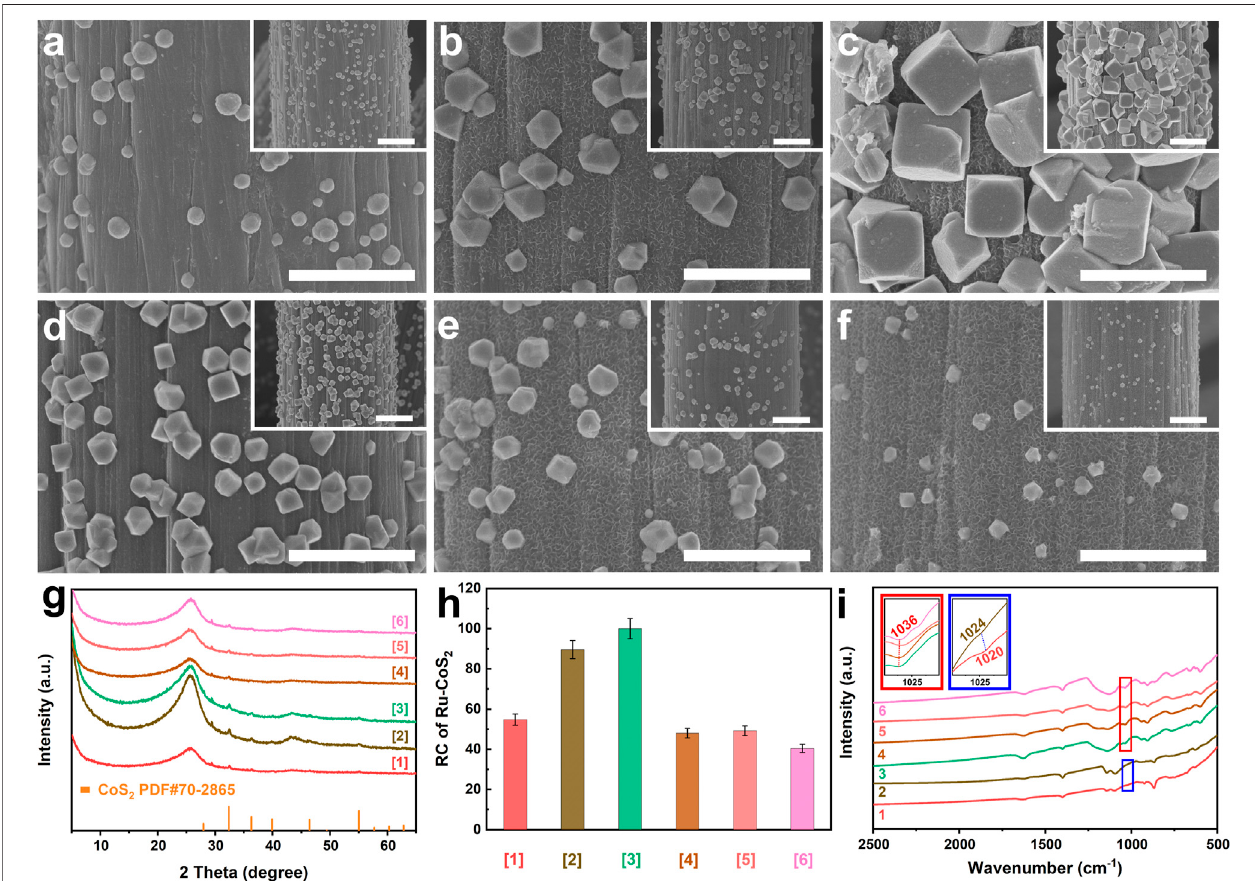
FIGURE4| SEMimagesof (A) [MoS 2 -CoS 2 /CC]([1]), (B) [Ru-MoS 2-x -CoS 2 /CC-1.0]([2]), (C) [thetypicalsamples]([3]), (D) [Ru-MoS 2-x -CoS 2 /CC-7.0]([4]), (E) [Ru- MoS 2-x -CoS 2 /CC-10.0] ([5]), and (F) [Ru-MoS 2-x -CoS 2 /CC-30.0] ([6]); (G) XRD patterns and (H) RC of Ru-CoS 2 of the corresponding samples; and (I) FT-IR spectra of the related samples. Meanwhile, 1, 2, 3, 4, 5, and 6 are MoS 2 -CoS 2 /CC, Ru-MoS 2-x -CoS 2 /CC-1.0, the typical samples, Ru-MoS 2-x -CoS 2 /CC-7.0, Ru-MoS 2-x -CoS 2 / CC-10.0, and Ru-MoS 2-x -CoS 2 /CC-30.0, respectively. Additionally, [1], [2], [3], [4], [5], and [6] are the corresponding samples synthesized at t = 6 h rather than 20 h.Theinsetsofpanels (A – F) arethelow-magni fi edSEMimagesofthecorrespondingsamples.Theinsetsinredandbluesolidlinesofpanel (I) arethehigh-magni fi ed images of panel (I) indicated in red and blue solid frames, respectively. Scale bars of panels (A – F) and their insets are 2 and 5 μ m.